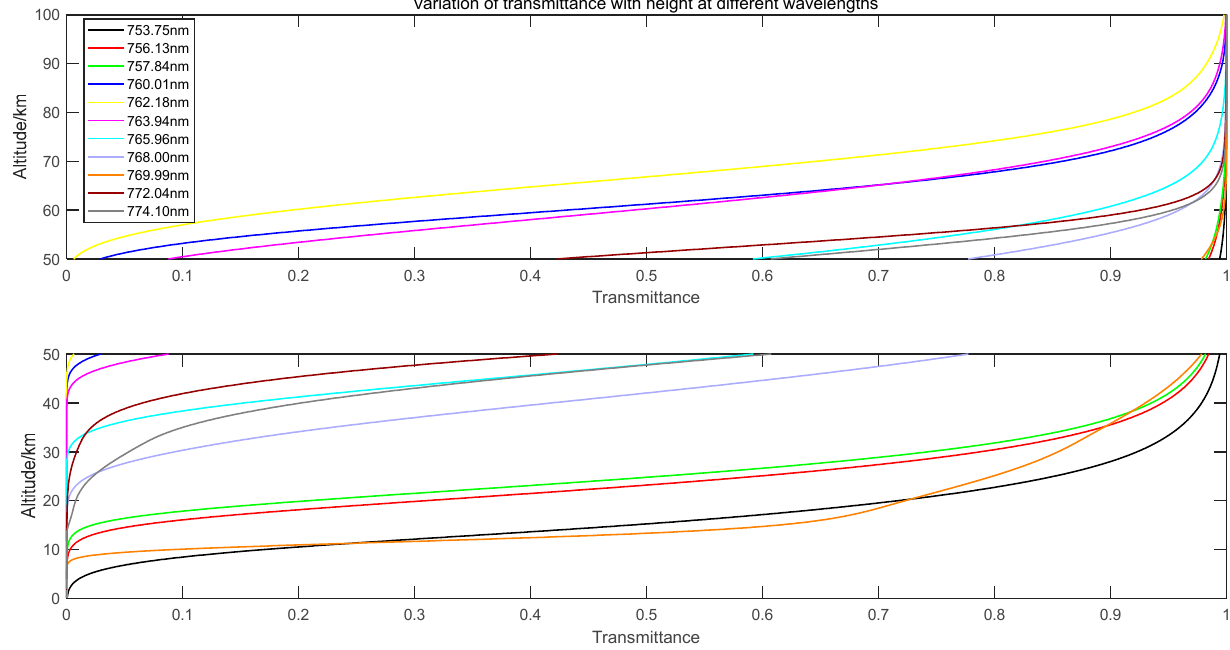
Figure 1. Variation of transmittance of 11 wavelengths at a low latitude in near space. The specific wavelengths were determined according to the HITRAN database. To better observe the altitude coverage of each wavelength transmittance, especially below 20 km and above 60 km, it is divided into two maps, with 50 km as the limit.